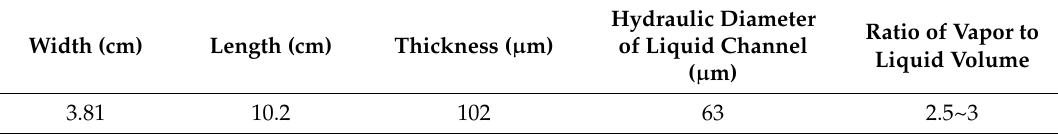
Table 1. Geometrical factors of the microwick